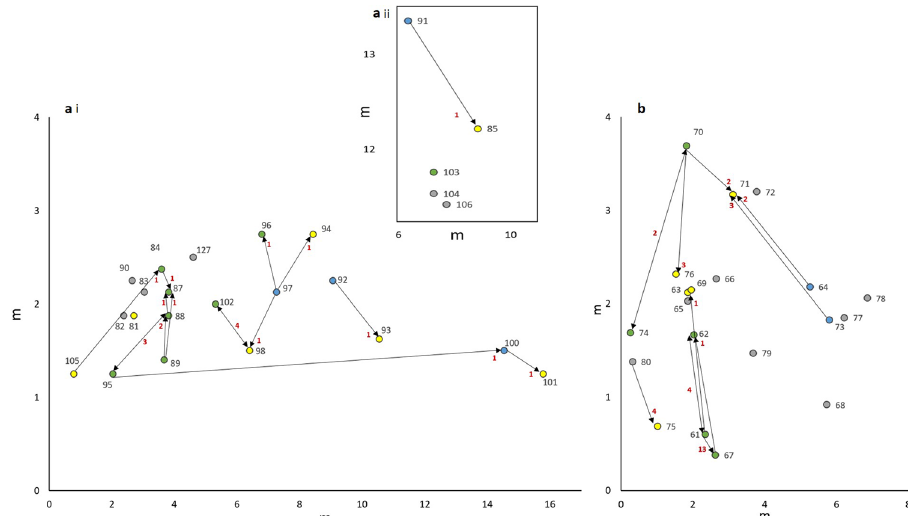
Fig. 2 Direction of gyne transport in the ant Cardiocondyla elegans . Location of colonies of the ant Cardiocondyla elegans in the collecting site RFRK (N 43° 55'43.9 ” , E 4°34'5.1 ” ) in 2015 ( a i and ii) and 2018 ( b ) in which the transport of female sexuals (gynes) by workers was observed. Shown are the exact localizations (in meters) of colonies used in the microsatellite analysis. Colonies marked by a yellow dot only received carried female sexuals (gynes) (yellow), colonies marked with blue only donated gynes, and colonies marked in green were both sources and recipients of gynes. Colonies not involved in gyne carrying are indicated in grey. Simple arrows indicate the direction of gyne transport. Double arrows indicate transport in both directions. Colored circles without arrows represent colonies for which the origin or destination of carried gynes could not be determined. The red numbers near the arrows indicate the total of transfers observed between individual nests. For the genetic analysis in 2015, we tried to maximize the number of nests involved, hence, the number of observed transfers between particular pairs of nests is lower than in 2018.